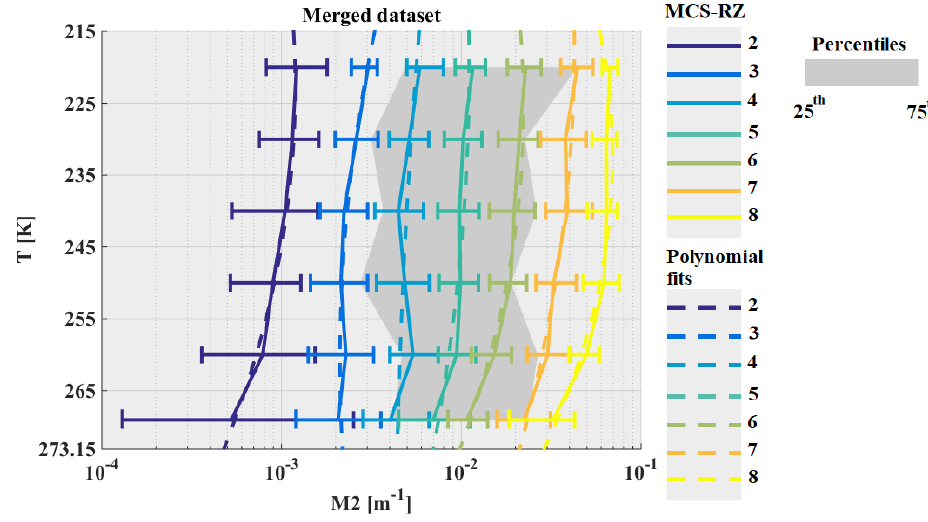
Figure 21. The same as Fig. 5 but for M 2 m − 1